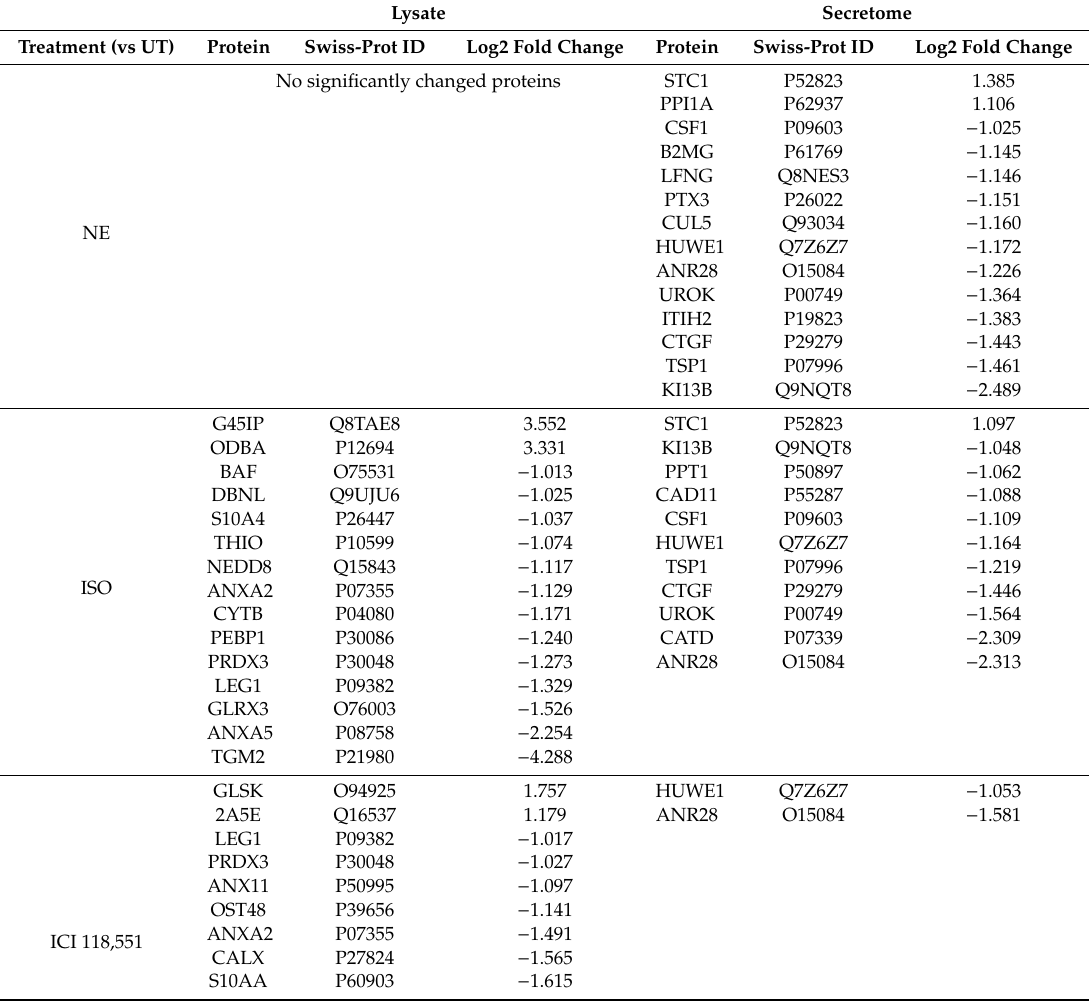
Table 2. Di ff erentially expressed proteins identified using SWATH MS analysis of MDA-MB-231 cell lysate and secretome following adrenoceptor agonism /